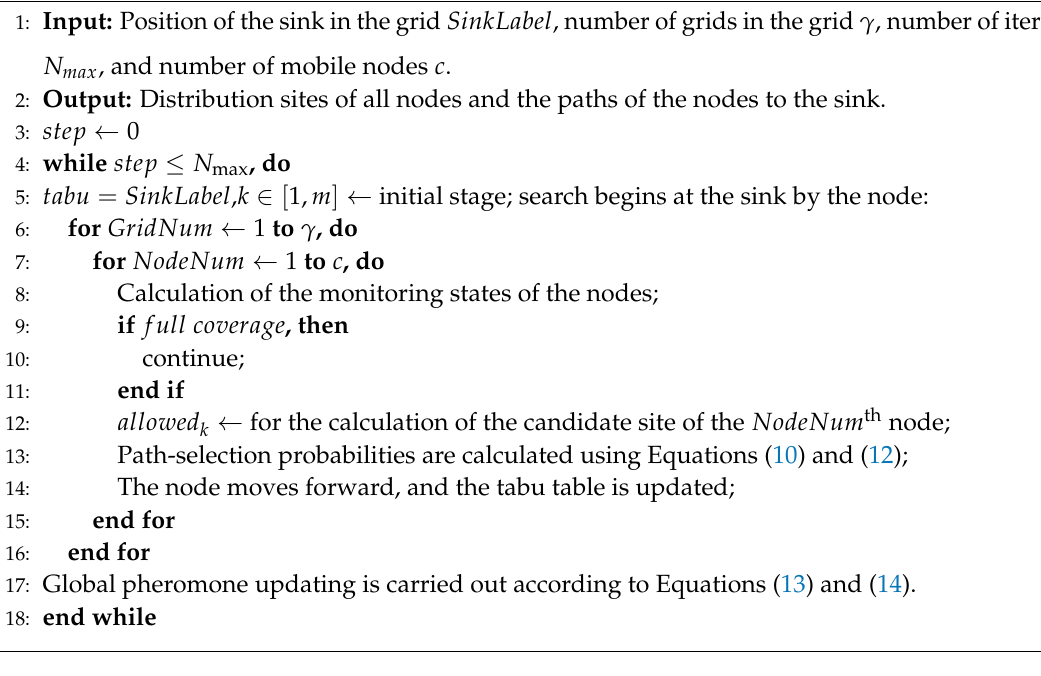
Algorithm 1 Detailed description of